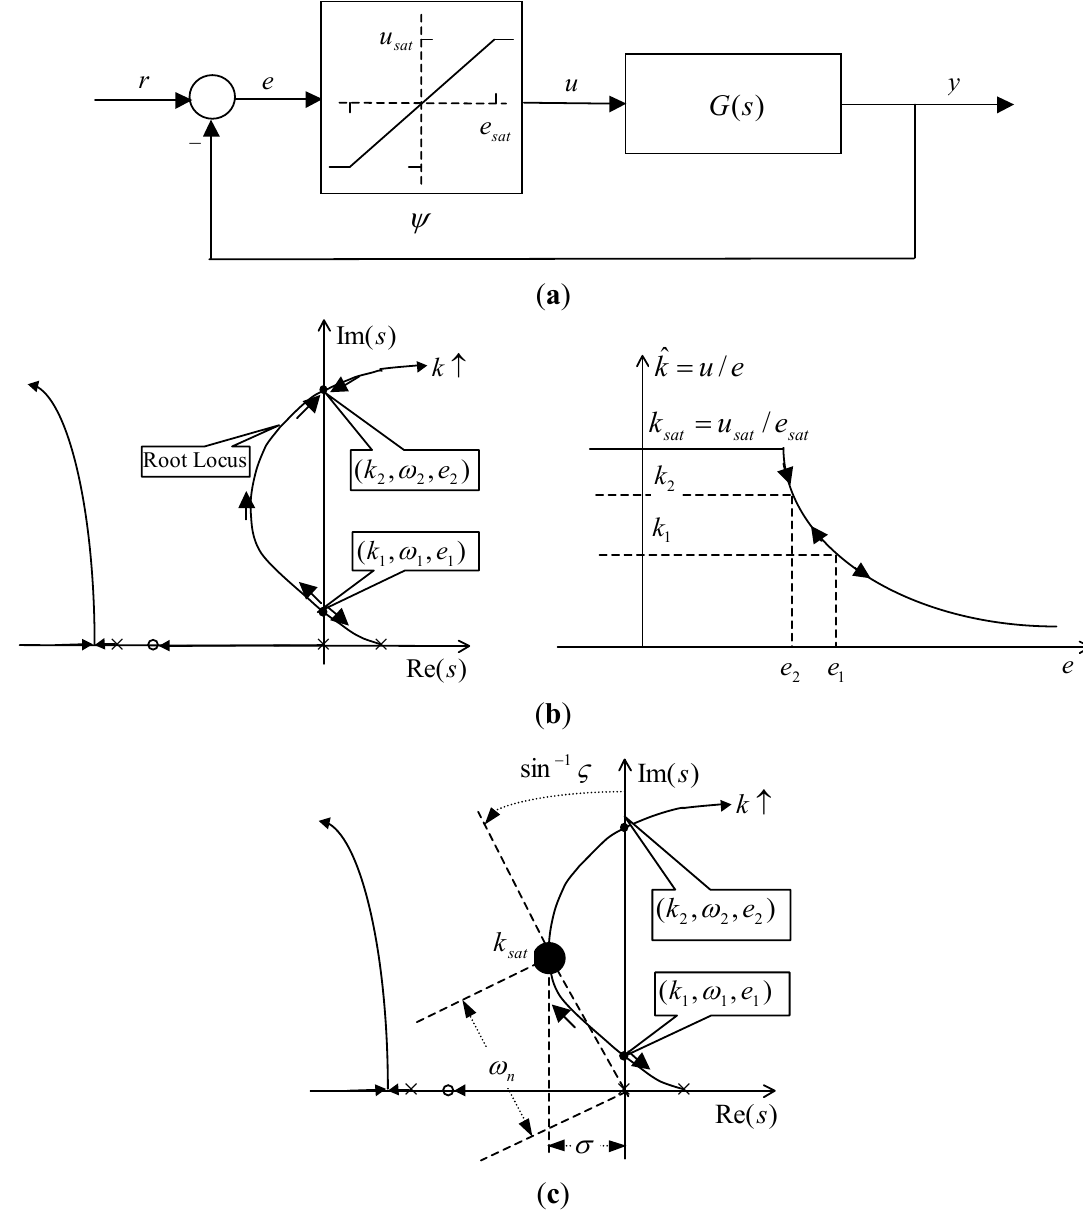
Figure 6. Dynamical Equilibrium Approach. ( a ) An example to study Dynamical Equilibrium; ( b ) Limited cycle and unstable cases; ( c ) Asymptotically stable case. e e e   : By a similar deduction, the closed-loop will asymptotically exhibit in limit-cycle (2) 2 0 1 with the frequency and amplitude identical with those of Case